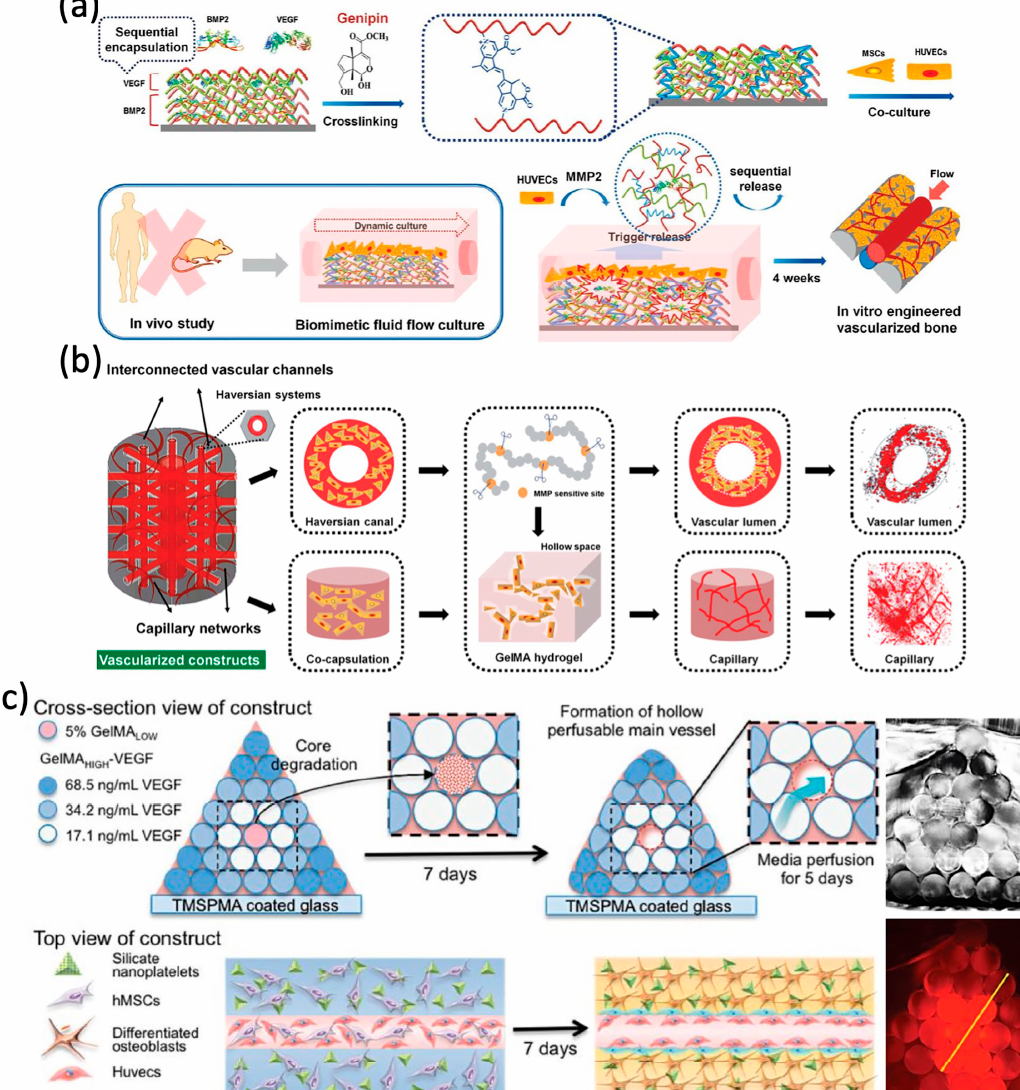
Figure 6. Growth factor-based approaches for vascular networks. ( a ) Schematic representation of sequential release of growth factors. ( b ) Schematic representation of microstructural design of vascularized construct. ( c ) Illustration of the bioprinting strategy for fabricating complex bone tissue architecture. Reprinted with permission from References [30,125,126] .